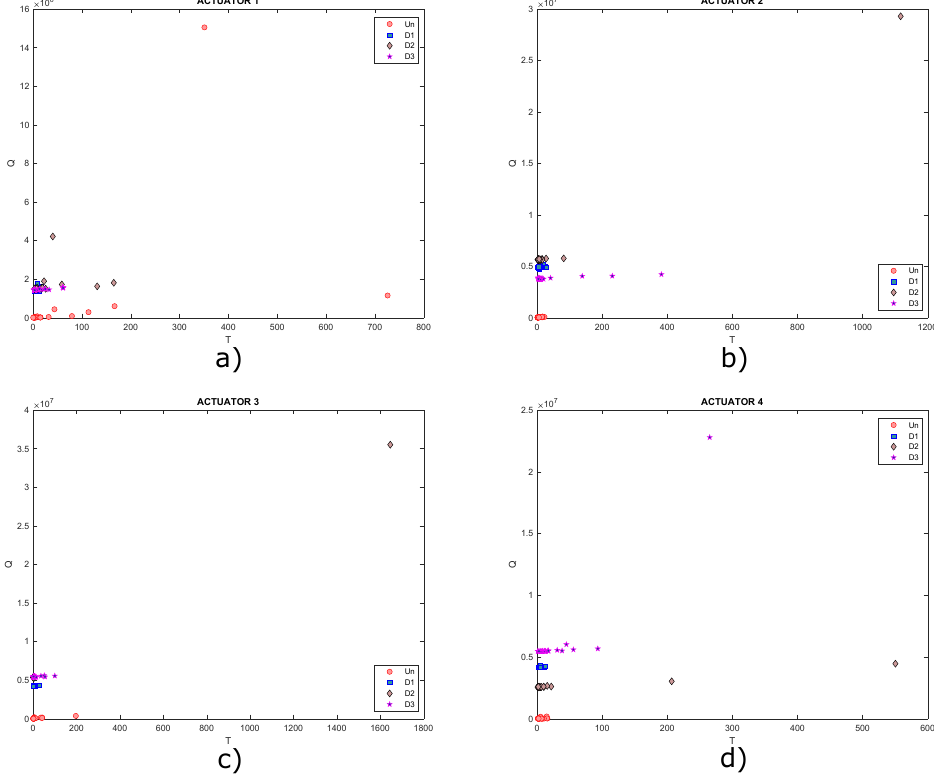
Figure 27. Graphs of T 2 vs. Q for actuation phases: ( a ) 1; ( b ) 2; ( c ) 3 and ( d )